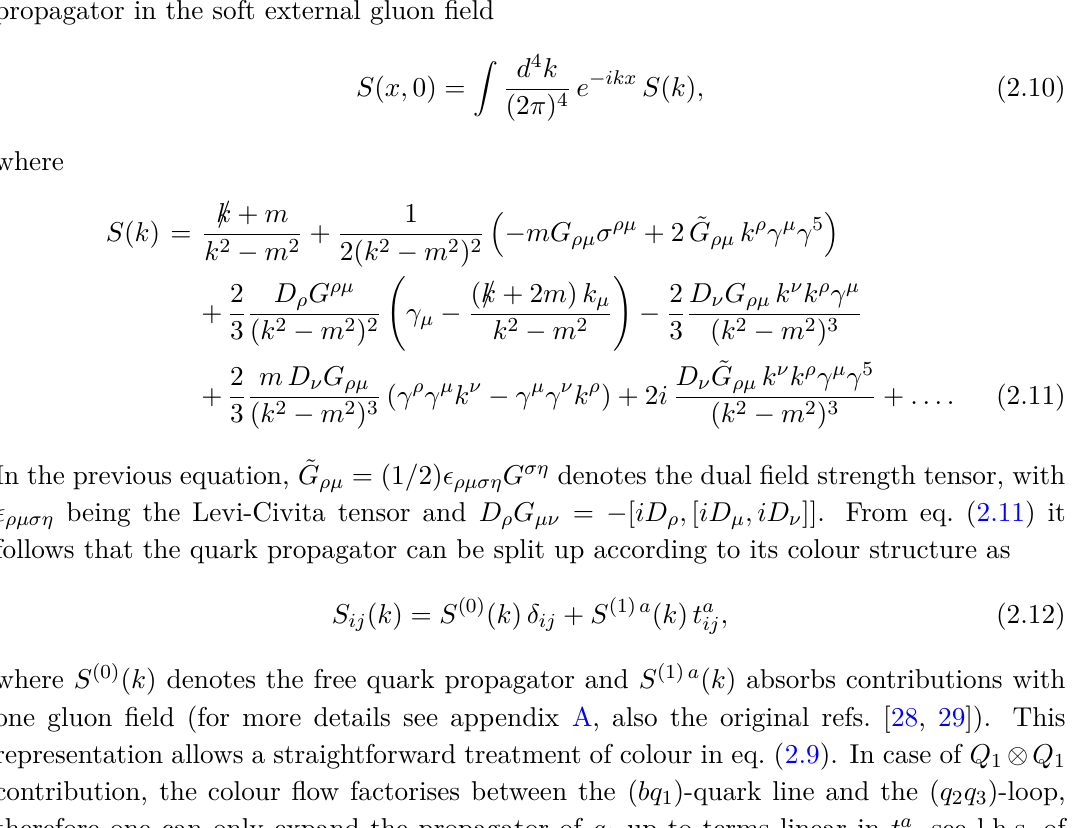
figure 2. Finally, in the case of the Q ⊗ T contribution, the colour flow forces the gluon 1 to be radiated off the ( q q ) -loop. Any interference term would be O (1 /m 4 2 3 sufficient to expand independently each of the two quark propagators in the loop (figure